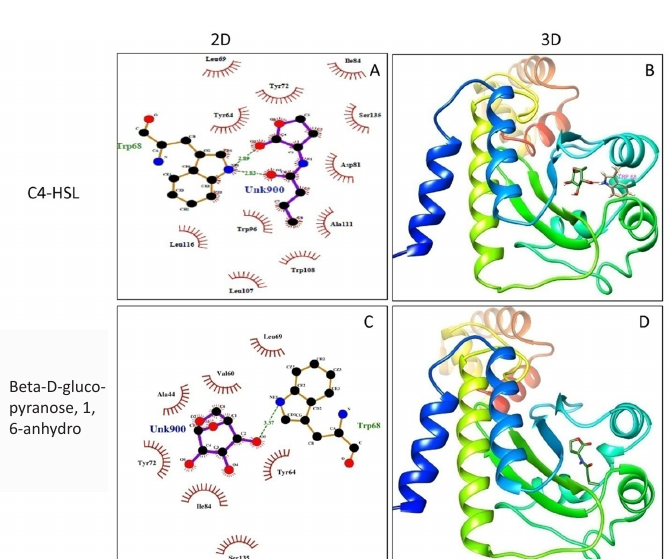
Fig. 6. Molecular docking studies of Beta-D-glucopyranose, 1, 6-anhydro from crude extract of P. tenuiflorus to study the binding affinity with the active site of the receptor protein, RhlR compared to the natural ligand (C4-HSL). (A) 2D docked conformation of C4-HSL (natural ligand) into the active site of RhlR; (B) 3D docked conformation of C4-HSL into the active site of RhlR, (C) 2D docked conformation of Beta-D-glucopyranose, 1,6-anhydro into the active site of RhlR, (D) 3D docked conformation of Beta-D-glucopyranose, 1,6-anhydro into the active site of RhlR.